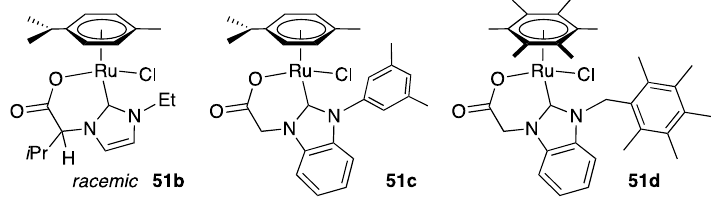
Figure 6. Carboxylate-functionalized NHC-Ru(II) complexes 51b – d .